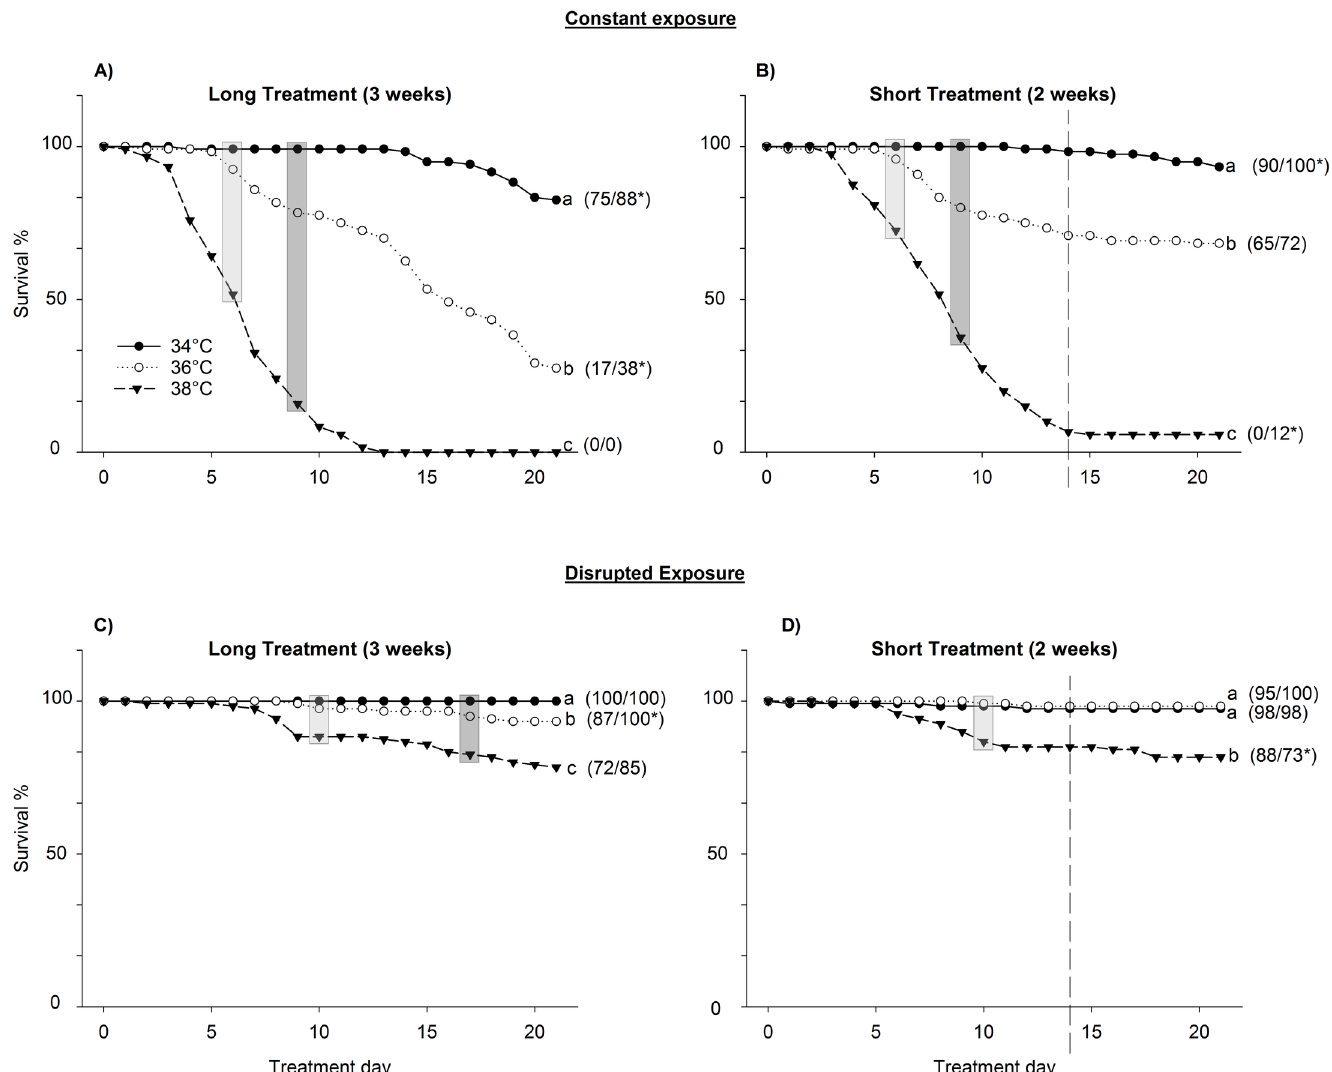
Fig 1. Survival of Cimex lectularius during heat stress. Survival during long (3 weeks) or short (2 weeks) heat stress in constant or disrupted temperatures. Numbers in brackets show percentage final survival of nymphs (left) and adults (right) in each treatment on day 21. (cid:3) denotes significant difference in survival between adults and nymphs during the whole heat stress period (Kaplan–Meier survival analysis, p < 0.05). Otherwise, the data of nymphs and adults were pooled. The dashed vertical line indicates where thermal stress was terminated in the short treatments. The total treatment period was 21 days, and bed bugs in the short treatments spent the last 7 days at 22˚C. Different letters (a, b, c, and d) denote significant differences (Kaplan–Meier survival analysis, p < 0.05) in survival between different heat treatments within each length-long/short combination. Rectangles indicate differences in mortality after experiencing a total of 6 (light grey) and 9 (dark grey) days at high